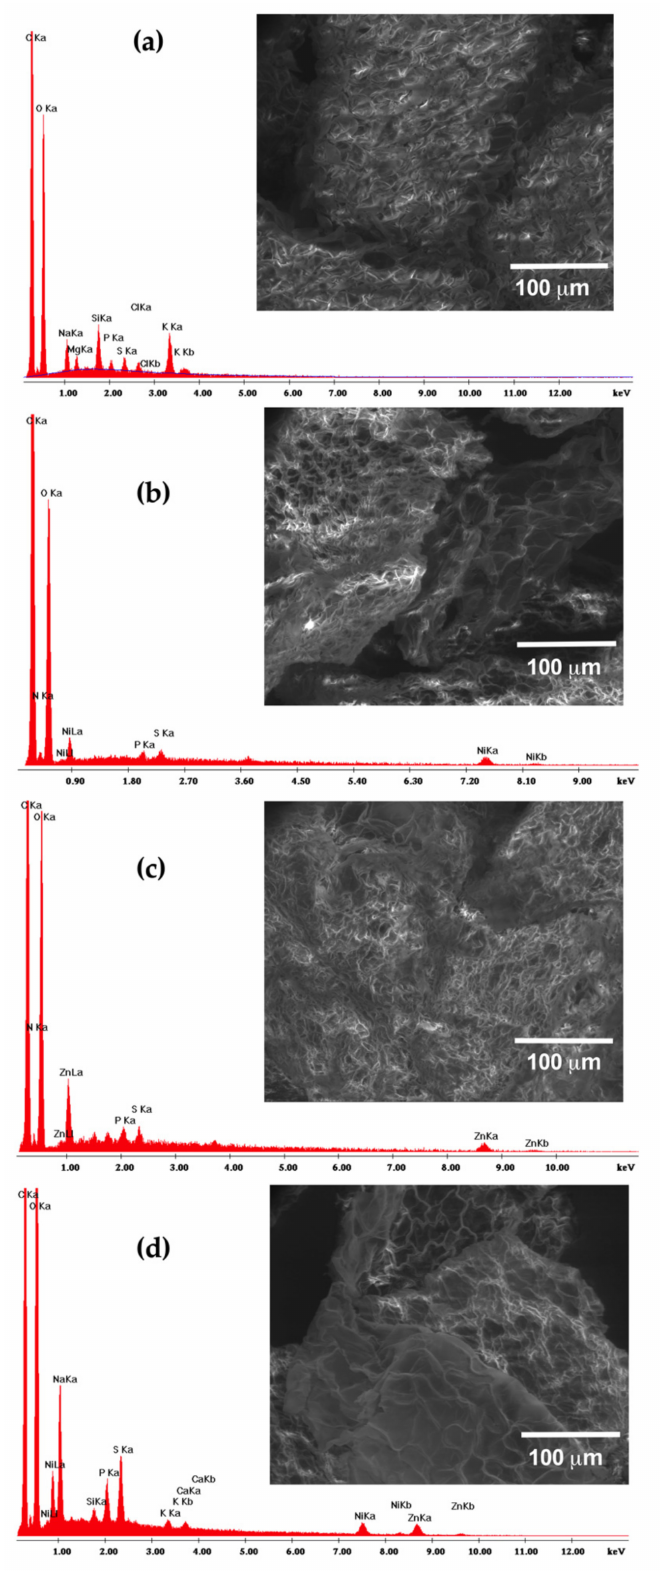
Figure 7. SEM-EDX micrographs of raw ( a ), Ni 2 + -loaded ( b ), Zn 2 + -loaded ( c ), and (Ni 2 + + Zn 2 + )-loaded ( d ) Lemna gibba